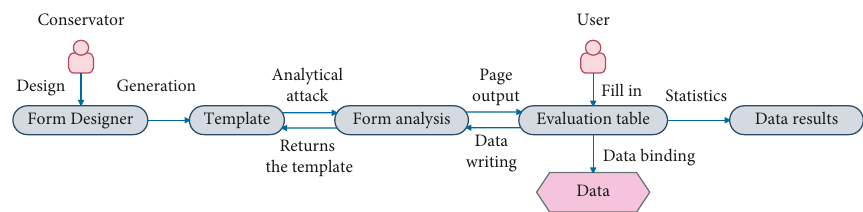
Figure 1: Business flow chart.